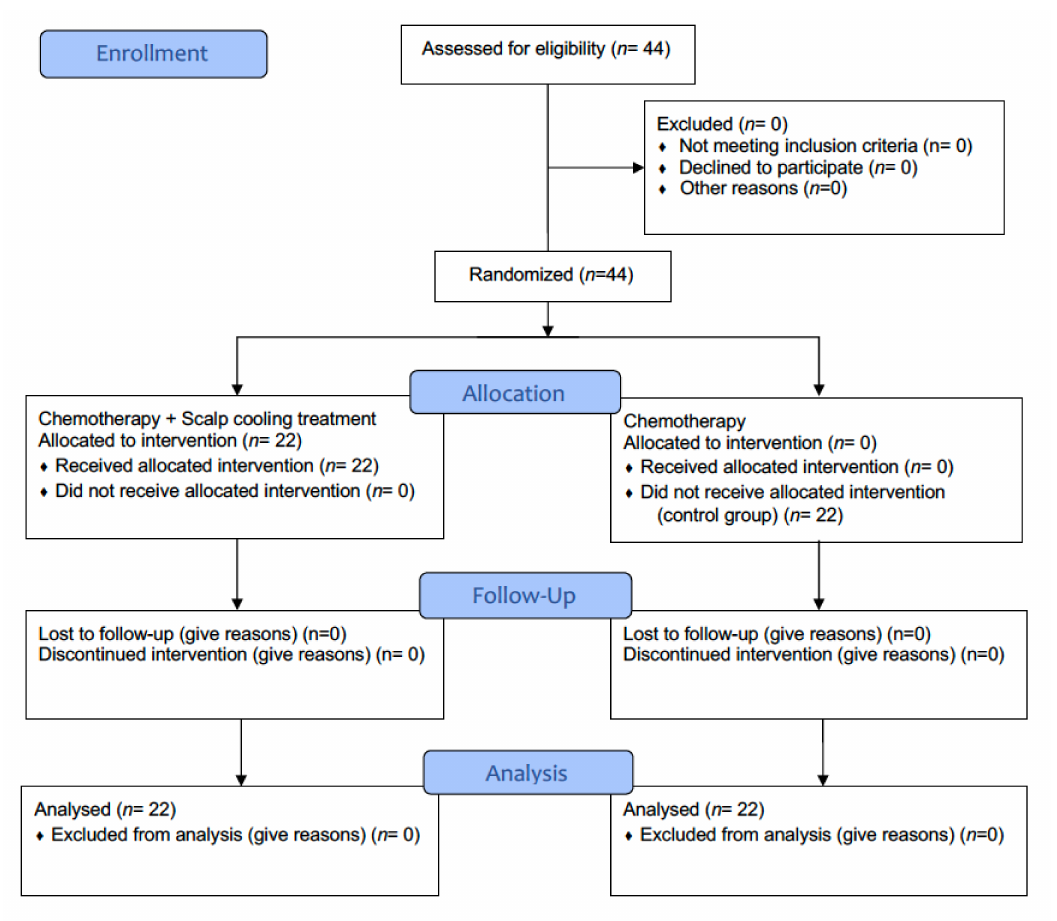
Figure 2. CONSORT Flow diagram for Research Protocol